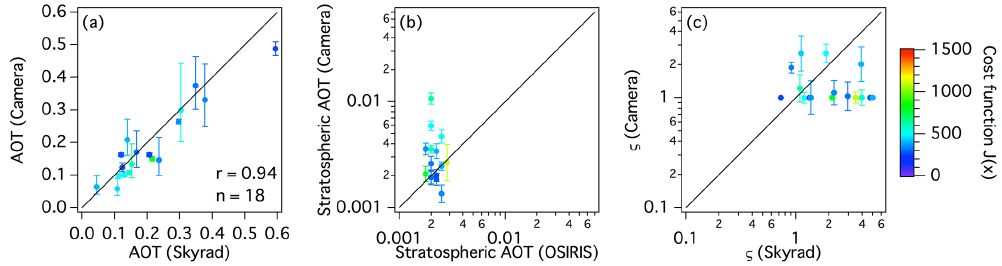
Figure 10. Comparison of aerosol property retrievals from camera measurements and sky radiometer measurements. Error bars show uncer- tainty of retrievals. Color scales show total retrieval cost J( x ) . The vertical axis and horizontal axis show retrievals from a camera and those from other instruments, respectively: (a) aerosol optical thickness, from camera and sky radiometer, with correlation coefficient r at 0.94 and 18 trials; (b) stratospheric aerosol optical thickness from camera and OSIRIS on board the Odin satellite; (c) coarse–fine particle volume ratio from camera and sky radiometer.